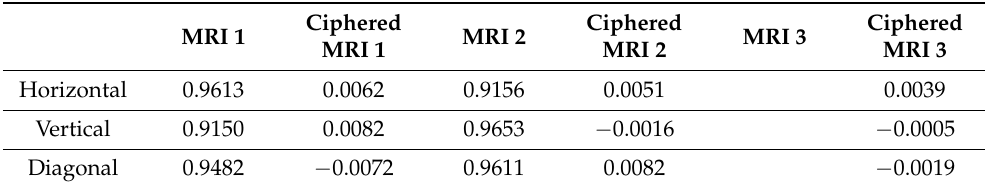
Table 3. CC values in the horizontal, vertical and diagonal directions of the original medical images and their encrypted